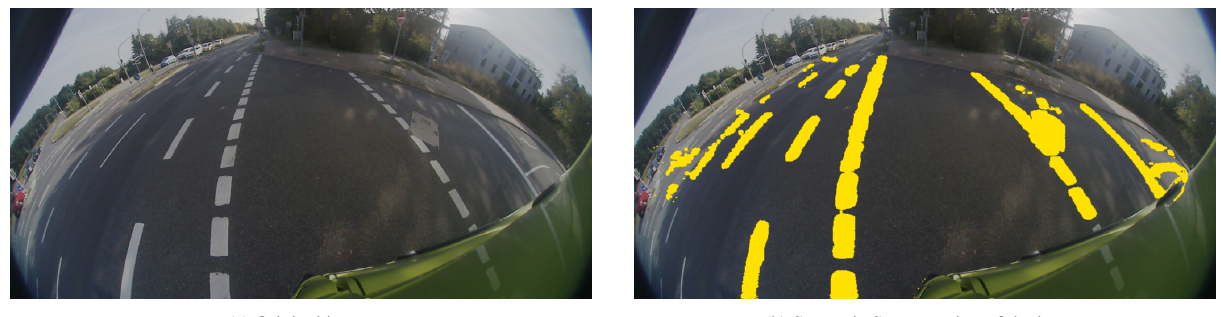
Figure 5. Semantic Segmentation representation of an exemplary image taken from a similar sensor setup. The image is taken from a camera on the front right corner of the truck and facing right. It was segmented pixel-wise to detect lane markings (yellow) on the